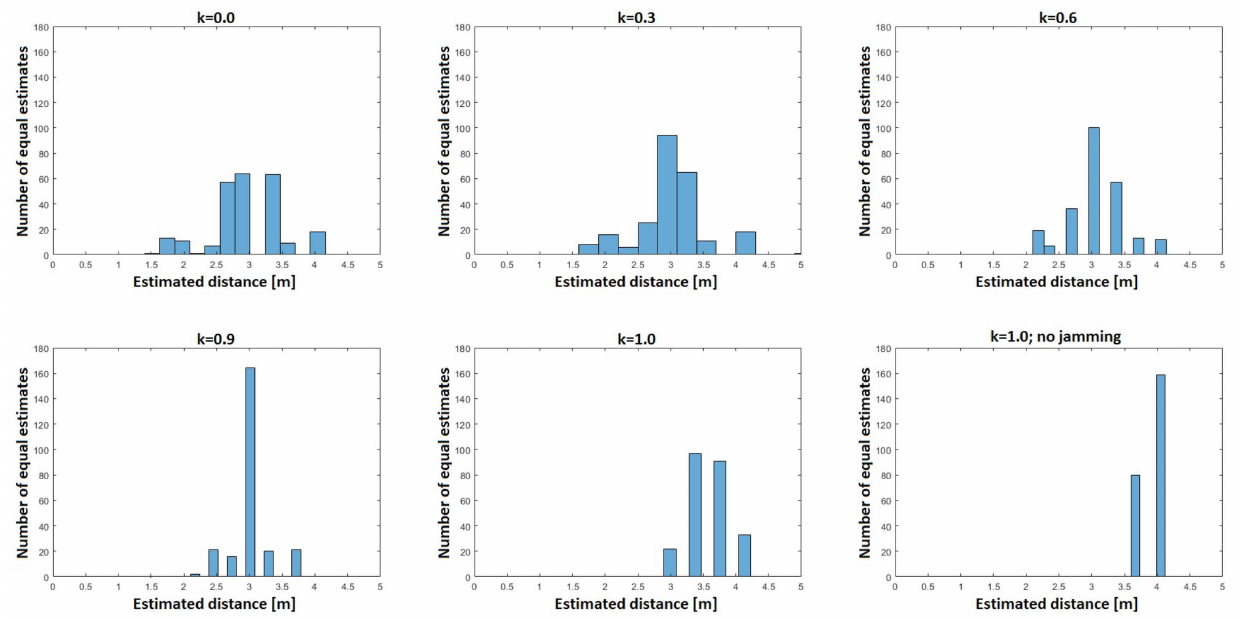
Figure 21. Histograms of distance estimation for various k